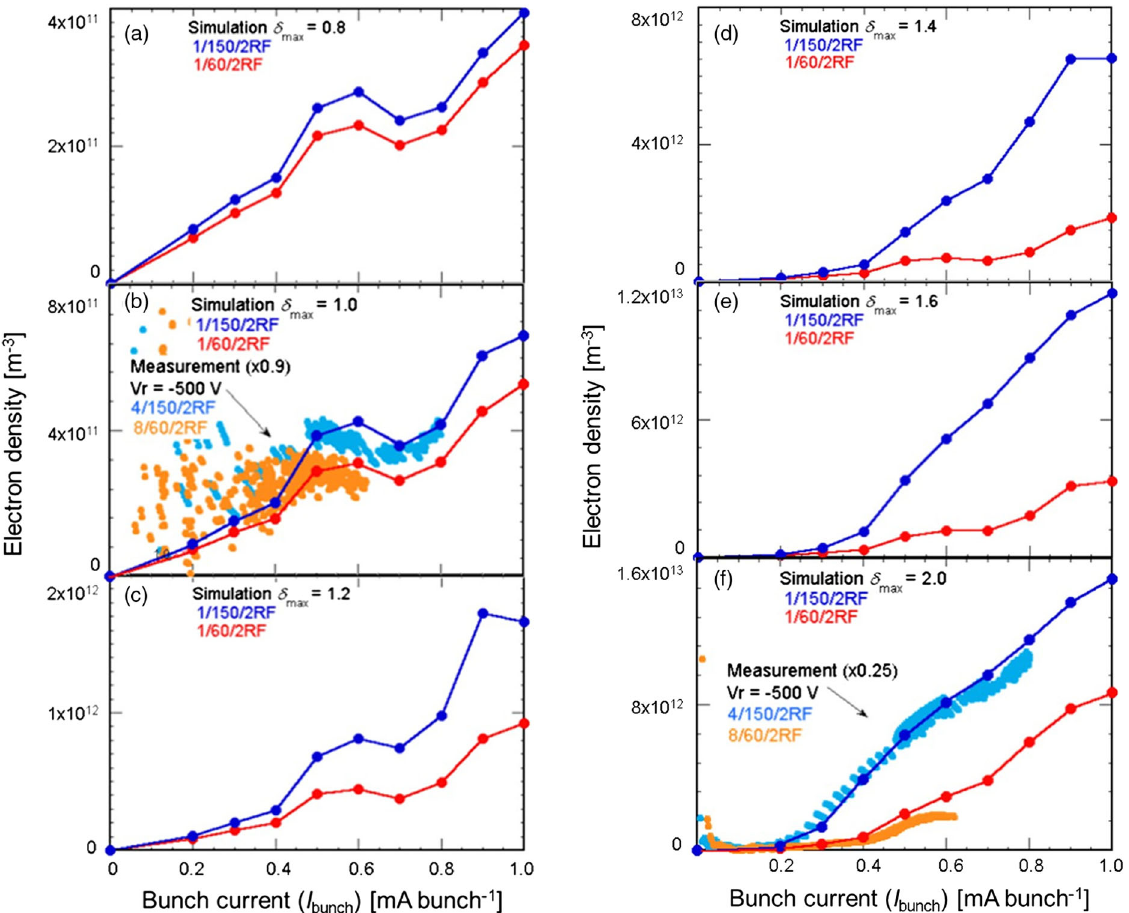
FIG. 19. Calculatedbehaviorsoftheelectrondensity( n e )withrespecttothebunchcurrent( I )forbunchfillpatternsof 1 = 60 = 2 RFand bunch 1 = 150 = 2 RF and δ from (a) 0.8, (b) 1.0, (c) 1.2, (d) 1.4, (e) 1.6, and (f) 2.0, respectively, where α ¼ 0 . 06 . Vertical scales are adjusted to max focus on the specific behavior. Measured behaviors of the electron density ( n e ) in the test beam pipe at the region with and without the TiN coating against the bunch current ( I ) at bunch fill patterns of 8 = 60 = 2 RF and 4 = 150 = 2 RF are also plotted in (b) and (f), respectively. bunch